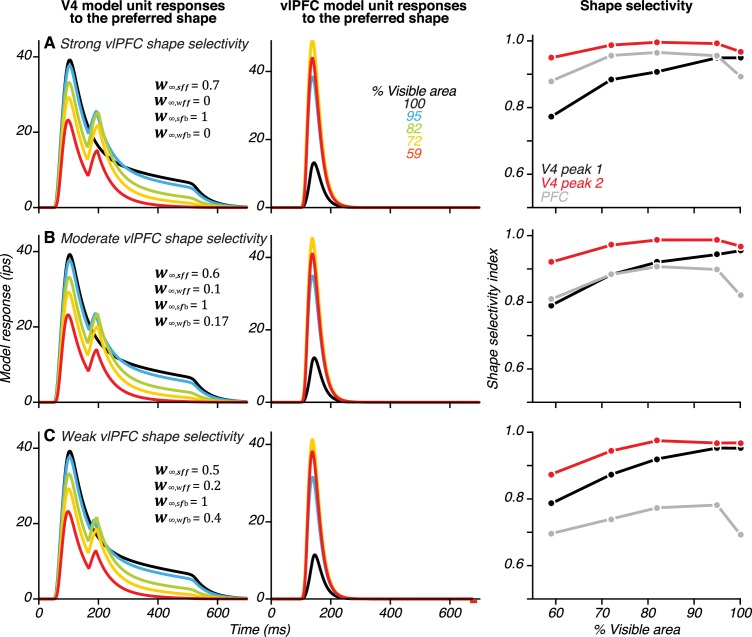
Relationship between the strength of shape selectivity in vlPFC in the model and the magnitude of V4 second peak responses produced.We varied the shape selectivity of vlPFC neurons by modifying the relative strengths of feedforward connections from the two V4 units (see parameters listed in A–C). For all three sets of parameters, V4 unit shape selectivity during the first peak (black) was strongest for the unoccluded shape and declined gradually for higher occlusions, as observed in the neuronal data. vlPFC shape selectivity (gray) was strongest for intermediate levels of occlusion, consistent with the neuronal data. vlPFC shape selectivity was weaker overall when the weights for the two V4 units were comparable (in C) and this resulted in a smaller second response peak in the V4 unit. However, in all three cases (A–C), V4 shape selectivity for the occluded shape was enhanced during the second peak. These simulations confirm that the model produces similar results for a range of vlPFC shape selectivity indices. In all cases, feedback connection strengths were proportional to feedforward connection strengths.